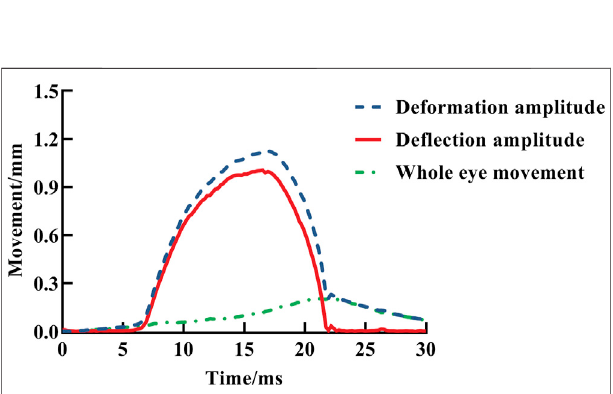
FIGURE 4 | Change of apex total displacement, apex pure displacement, and eye globe movement with time, indicated by blue dotted line, red solid line, and green dotted line,